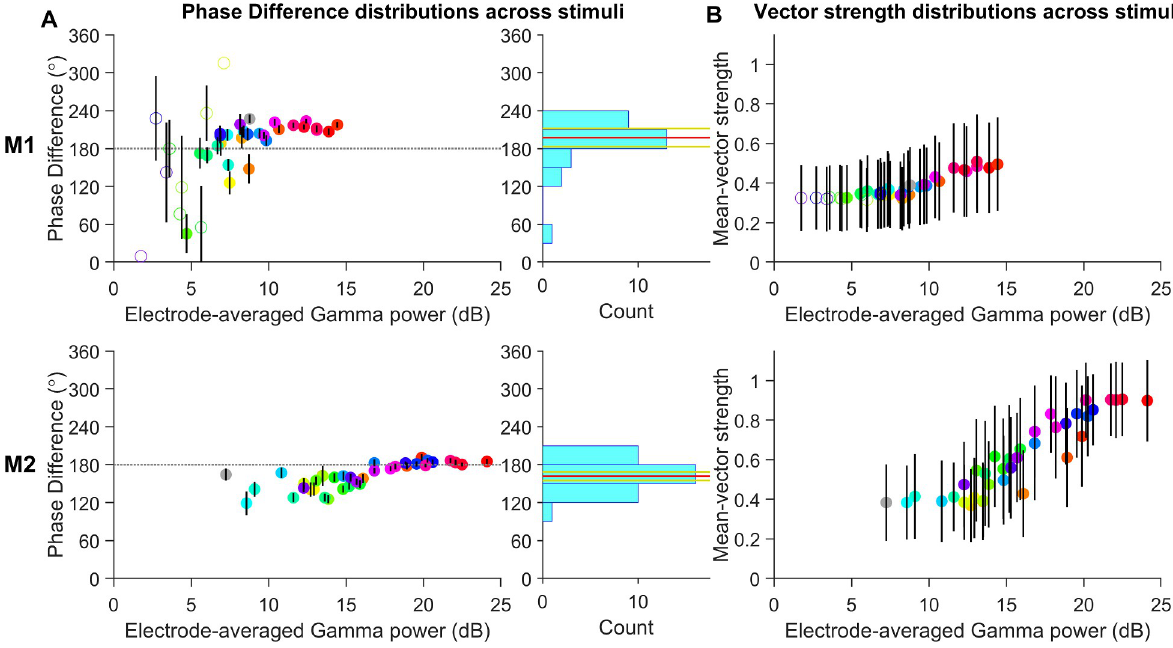
Fig 5. Gamma-harmonic phase differences in different stimuli are concentrated near 180˚. (A) Circular mean of trial-averaged gamma- harmonic phase differences (across all electrodes) are scattered against the average gamma power for each stimulus (circles are colored to represent the presented hues; grey for grating stimulus). For each stimulus, the pool of trial-averaged phase differences from all electrodes is subject to Rayleigh test of non-uniformity to check if phase-difference is consistent across electrodes so that circular mean estimates are reliable (p- value < 0.01). If found reliable (even though it could be different from 180˚), the stimulus is represented by a filled circle. Error bars represent the 95% confidence interval of circular mean. The histograms on the right show the distribution of the electrode-averaged phase differences of stimuli with reliable circular mean estimates (filled circles). The circular mean ± 95% confidence interval of this distribution are represented by the red and yellow lines horizontal respectively. (B) The mean vector strengths for the different stimuli are distributed against the average gamma power for each stimulus, similar to